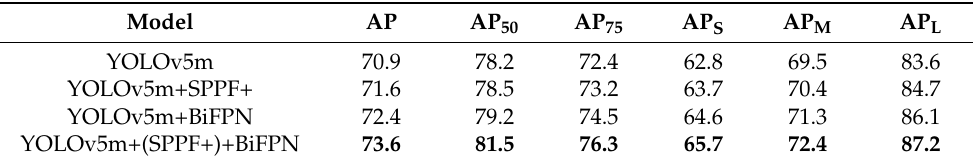
Table 11. Comparison results of the ablation